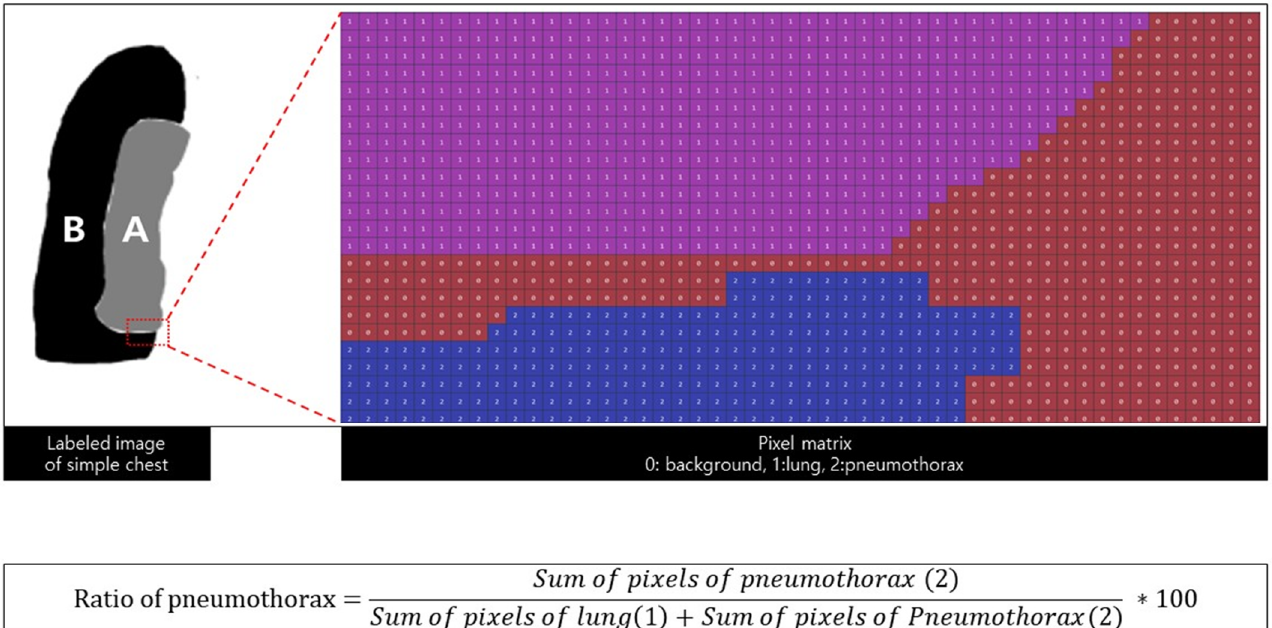
Figure 3. Labeling and pixel matrix A is the area of the lung, and B is the area of the pneumothorax. The area of the pneumothorax is equal to the sum of the pixel matrix, and the calculated ratio of the pneumothorax is defined as the predicted label.